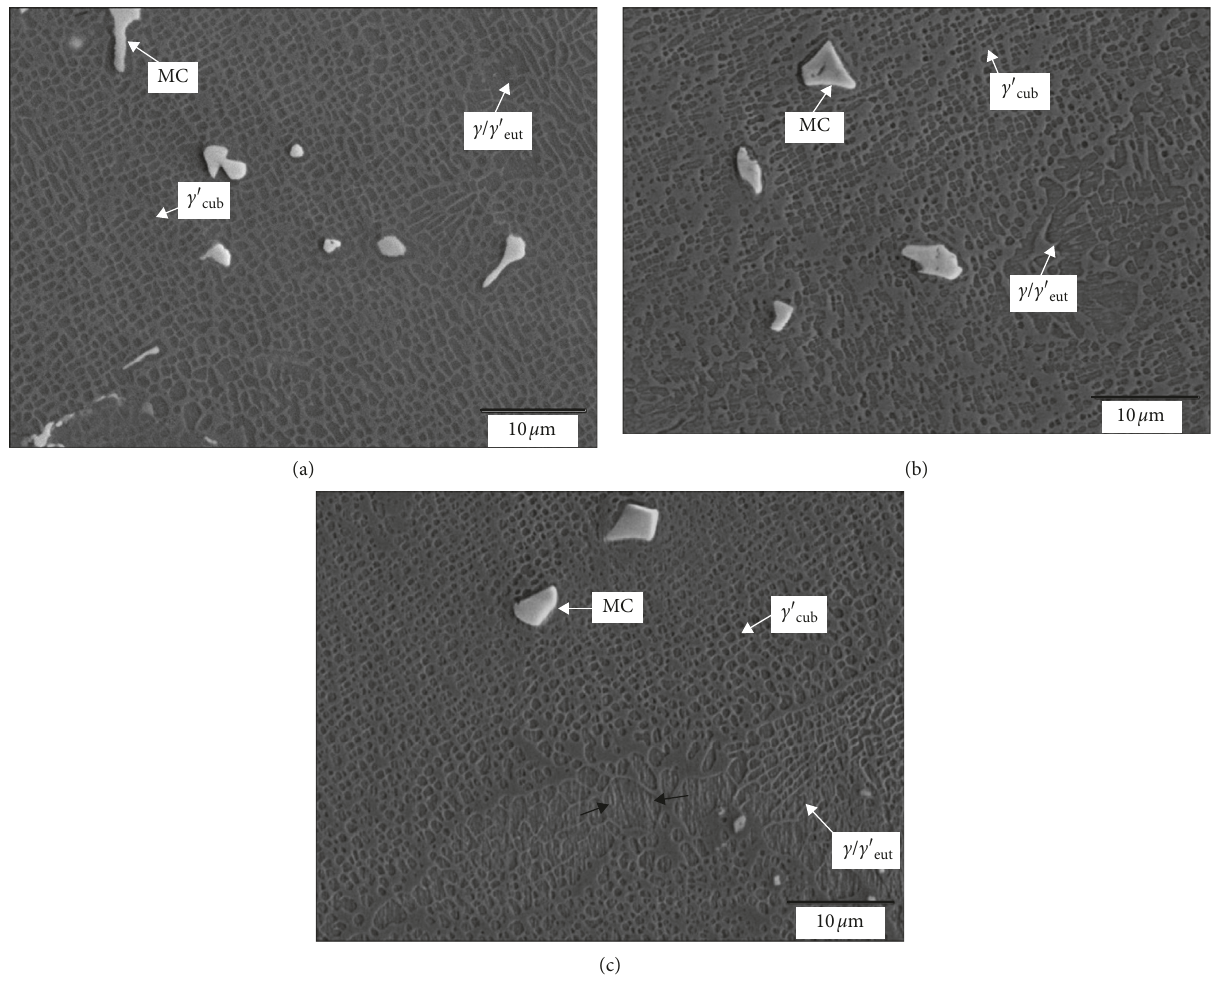
Figure 9: SEM micrographs of IN-792 superalloy for (a) MT: 1147K (874 ° C); (b) HT: 1211K (938 ° C); (c) LT: 1091K (818 °